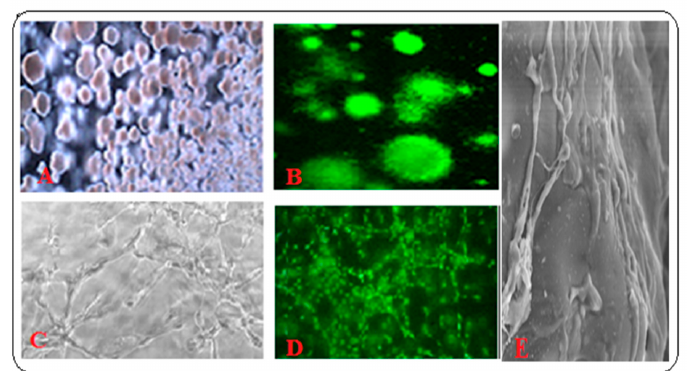
Figure 5. HSC from BM grown on PLGA-hydroxyapatite (HA) scaffold: ( A ) Bright field image of the spheroid colonies; ( B ) Fluorescent image after staining the colonies with acridine orange-ethidium bromide stains; ( C , D ) 3-D BM- MSCs and HUVEC co-cultures on PLGA-HA and Matrigel scaffold, ( E )- SEM image of MVs. All other microscope images were taken using 5× objective.